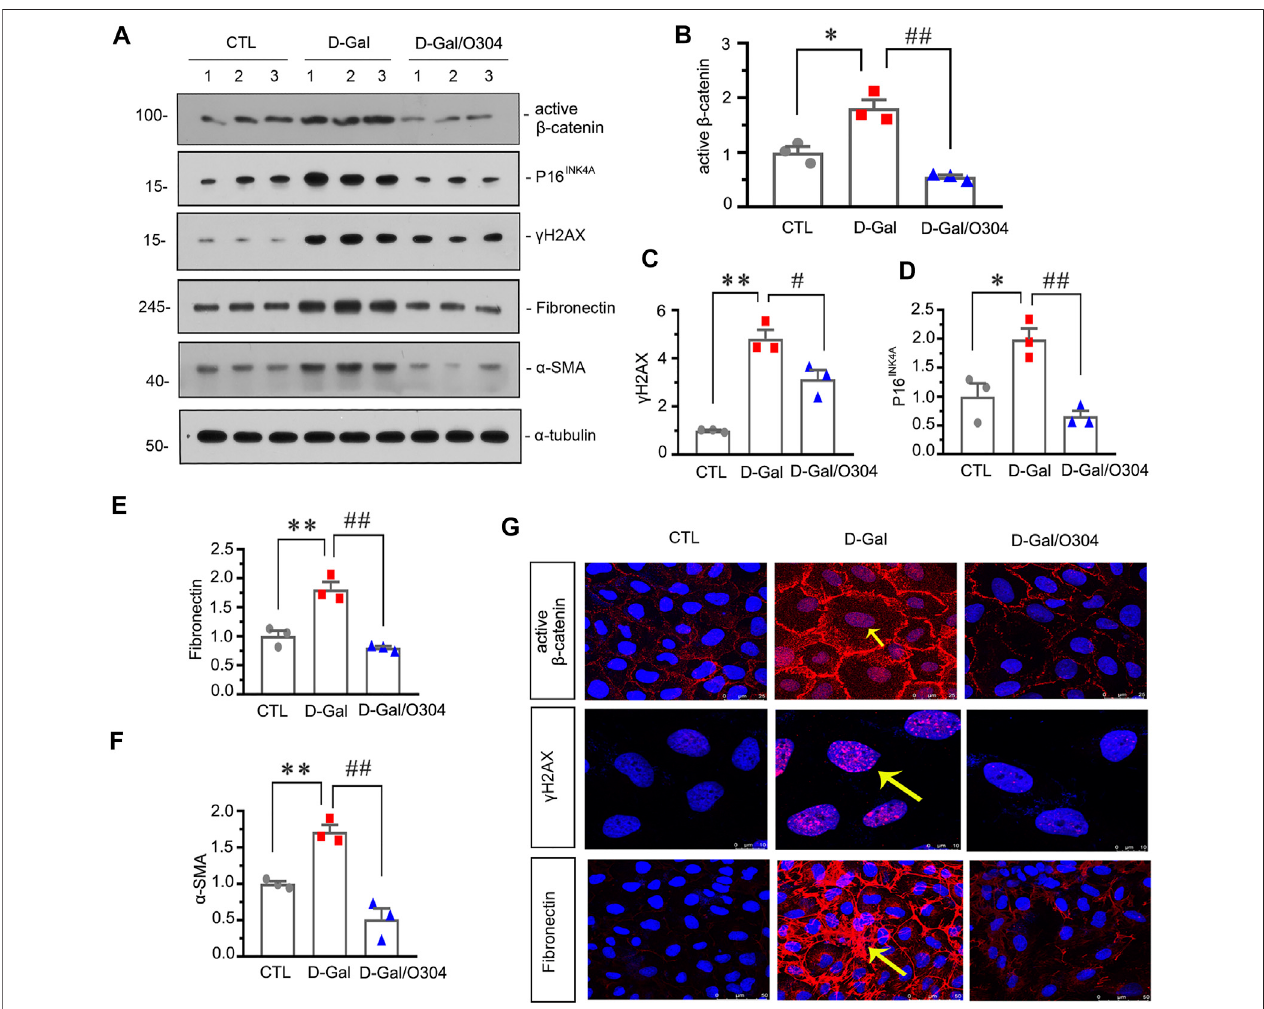
FIGURE 8 | O304 could inhibit β catenin and alleviate renal senescence and fi brosis in vitro . (A – F) Representative western blot and quantitative data showing the expression of active β -catenin, P16 INK4A , γ H 2 AX, fi bronectin and α -SMA in HKC-8 cells. HKC-8 cells were pretreated with O304 at 50 nM for 1 h, followed by treatment with D-Gal at 10 mg/ml for 60 h * p < 0.05, ** p < 0.01 versus the control group alone; # p < 0.05, ## p < 0.01 versus the D-Gal-treated group alone ( n = 3). (G) Representative micrographs showing the expression of active β -catenin (top), γ H 2 AX (middle) and fi bronectin (bottom) in HKC-8 cells. HKC-8 cells cultured on coverslips were immunostained with an antibody against active β -catenin, γ H2AX or fi bronectin. Arrows indicate positive staining.